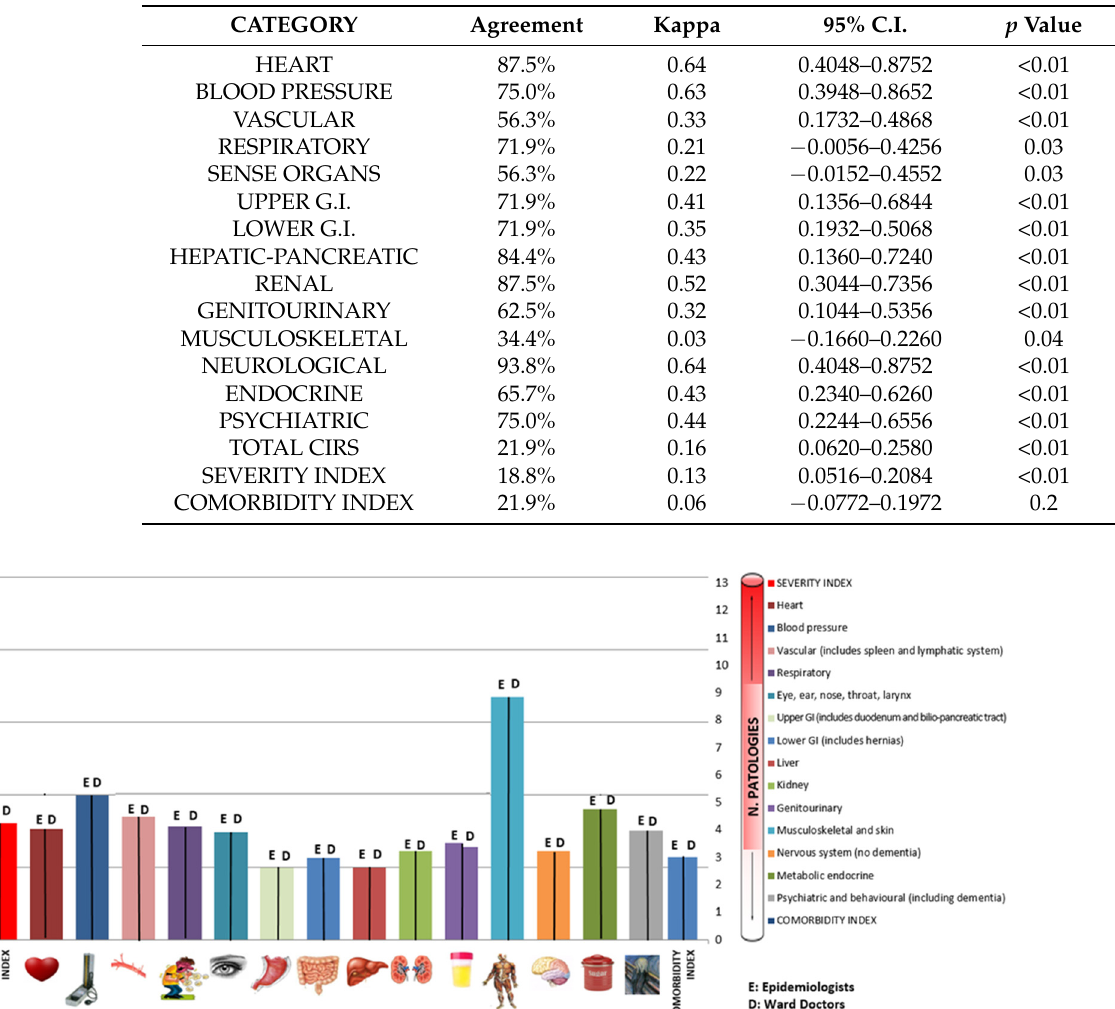
Figure 5. Concordance between epidemiologists and ward doctors (third control). Table 3. Levels of agreement between the CIRS values reported by the pool of epidemiologists and ward doctors (third control).